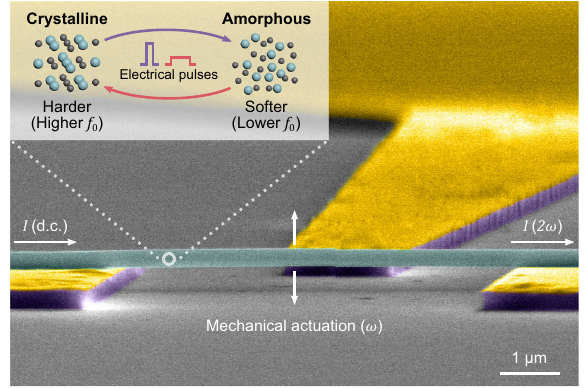
Fig. 1 Annotated SEM image of the phase-change NEMS device. The GeTe nanowire with a diameter of ~300 nm is suspended and anchored by Au electrodes. The device is piezoresistively transduced using a d.c. bias source. Symmetrical vibrations of the resonator modulate the d.c. current through the device at a frequency of 2 ω , doubling the actuation frequency ω . (Inset) The concept of phase-change tuning. Electrical pulses alter the crystallinity of the resonator between a softer amorphous lattice and a harder crystalline lattice, resulting in active tunability of f 0